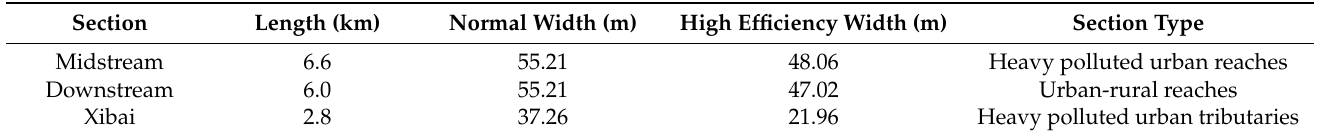
Table 5. High efficiency VBZ width of DX River section in urban areas.